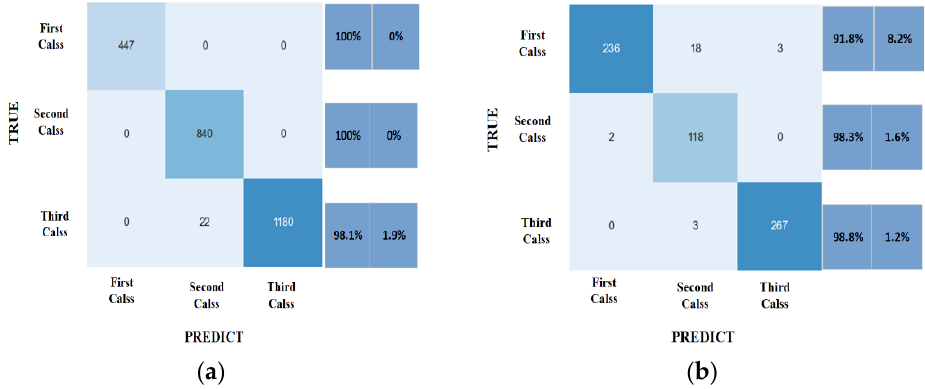
Figure 8. Confusion matrix of the Inception V3-LSTM. ( a ) Training set; ( b ) Validation set.